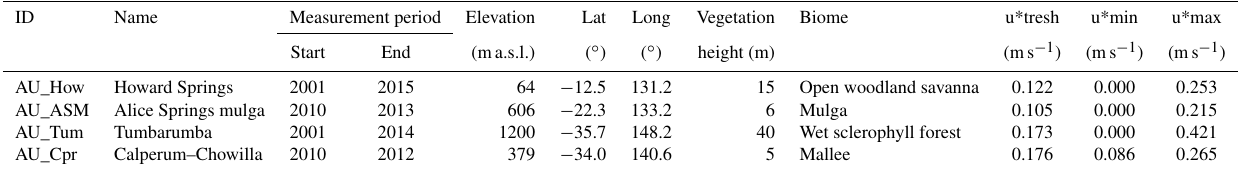
Table 1. OzFlux sites presented in this study – location and additional